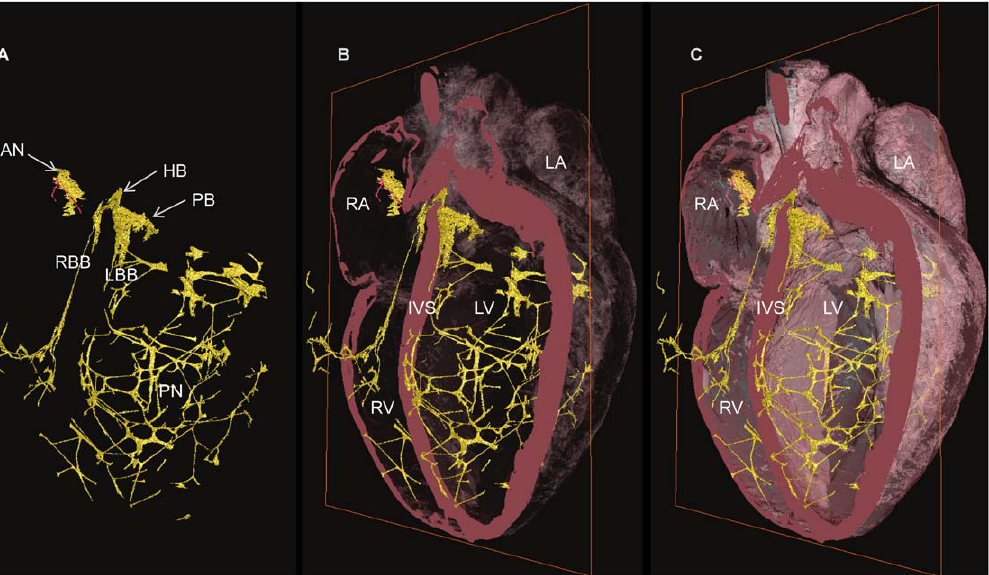
Figure 6. 3-D representation of the CCS in failed rabbit heart. Segmented 3D surface showing the three major components of the CCS (yellow) overlaid with the longitudinally cropped cardiac mass (pink). Decreasing levels of cardiac mass transparency (A-C) show the true in situ position of the CSS. HB- His bundle, IVS- interventricular septum, LA- left atrium, LBB- left bundle branch, LV- left ventricle, PB- penetrating bundle, PN- Purkinje network, RA- right atrium, RBB- right bundle branch, RV- right ventricle, SAN- sinoatrial node.